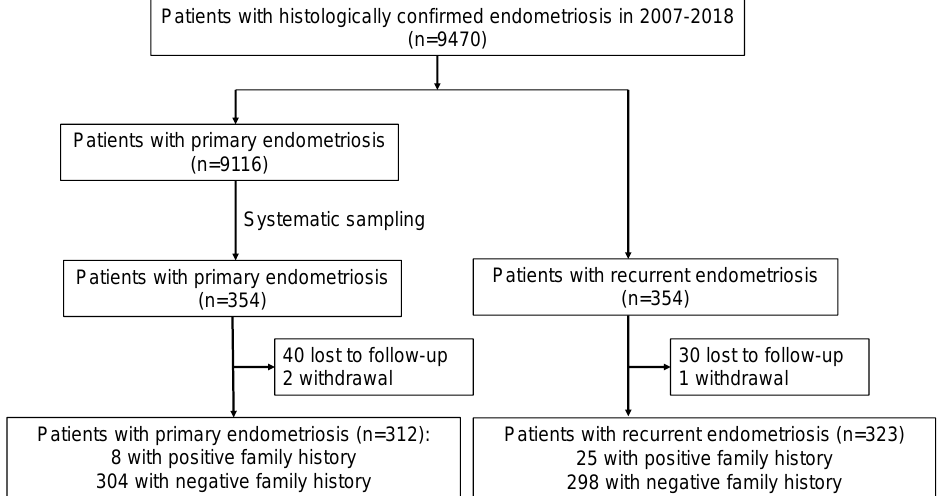
Figure 1. Flowchart of patients’ enrollment.